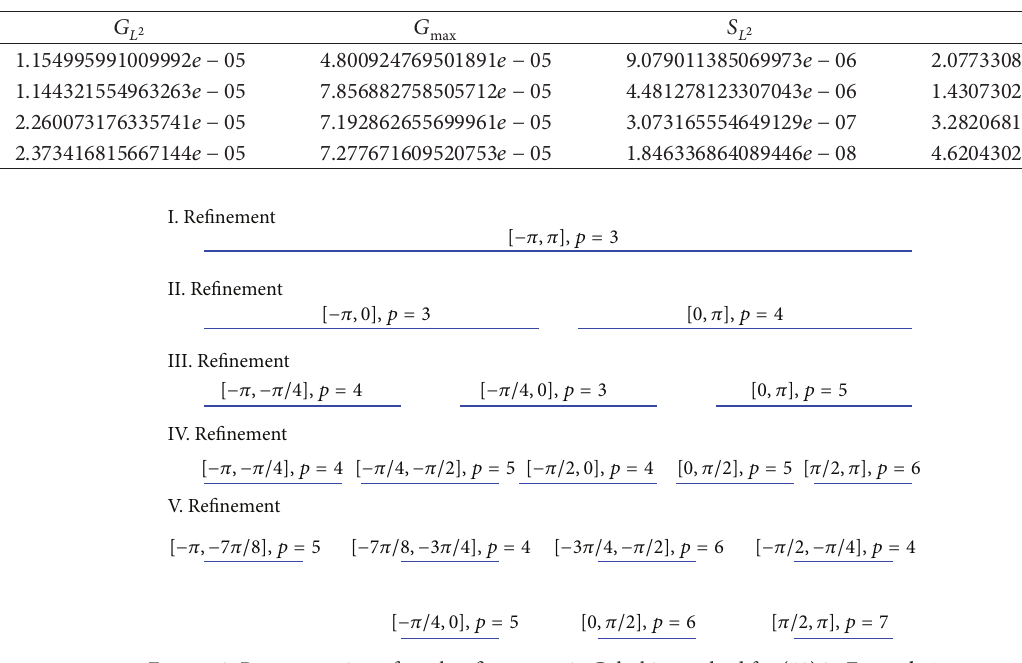
Figure 3: Representation of mesh refinement via Galerkin method for (42) in Example